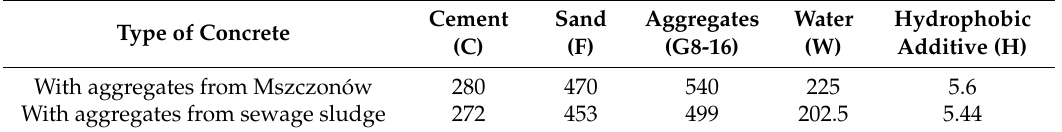
Table 1. Composition of light concretes applied per 1 m 3 (kg).